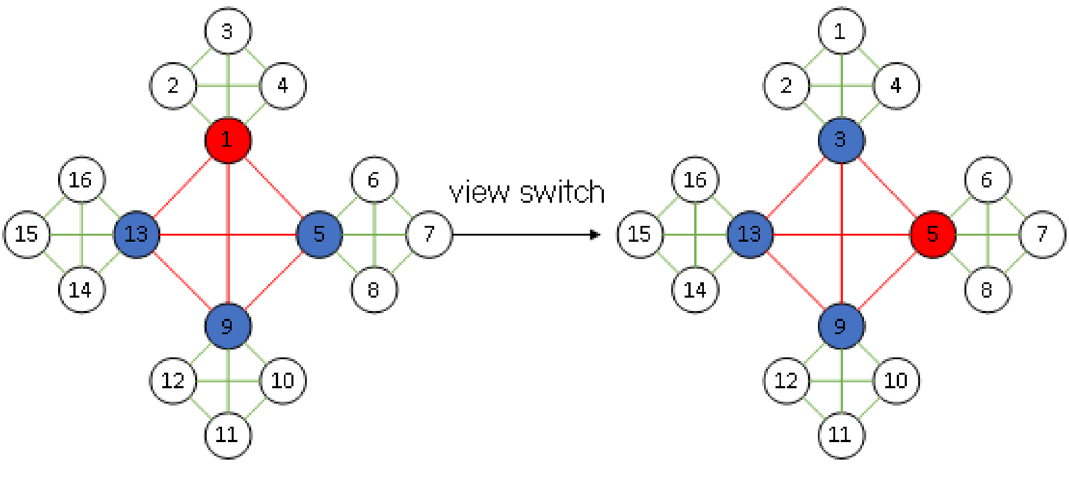
Figure 3. View replacement